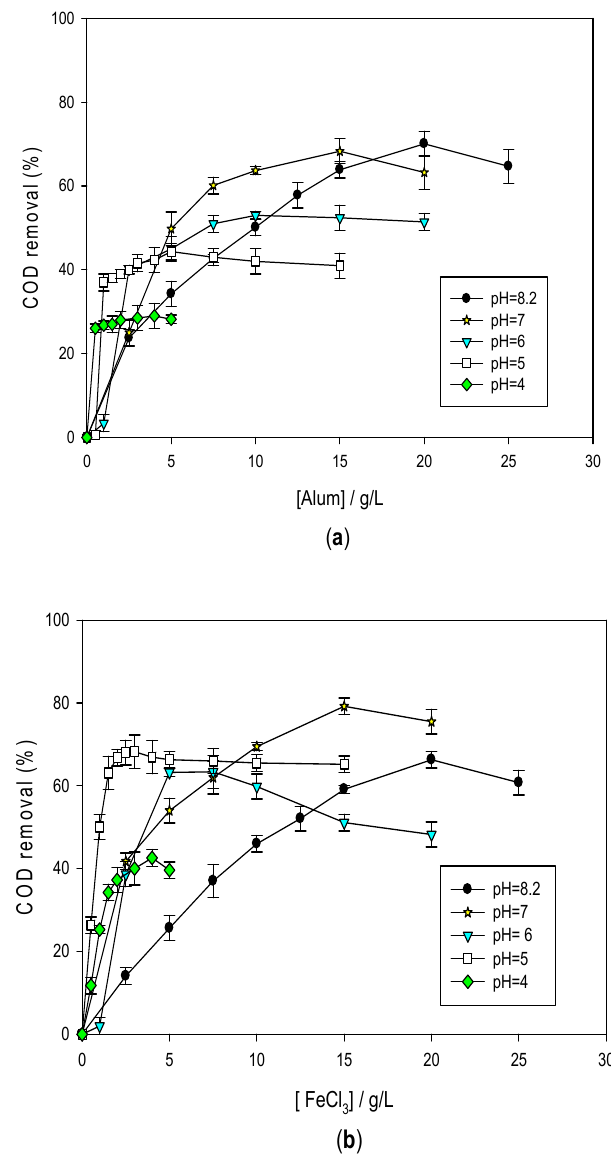
Figure 2. Removal of COD at initial pHs with ( a ) alum and ( b ) ferric chloride.